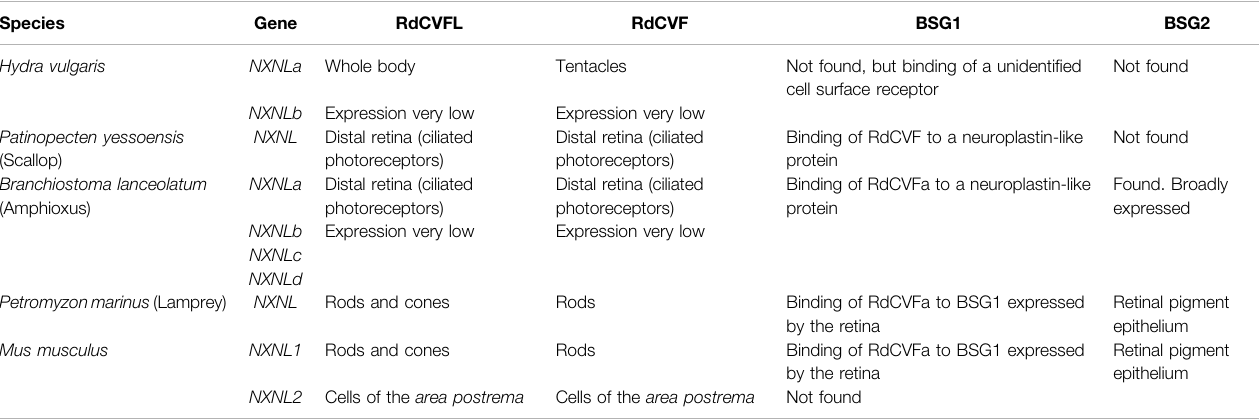
TABLE 1 | Summary